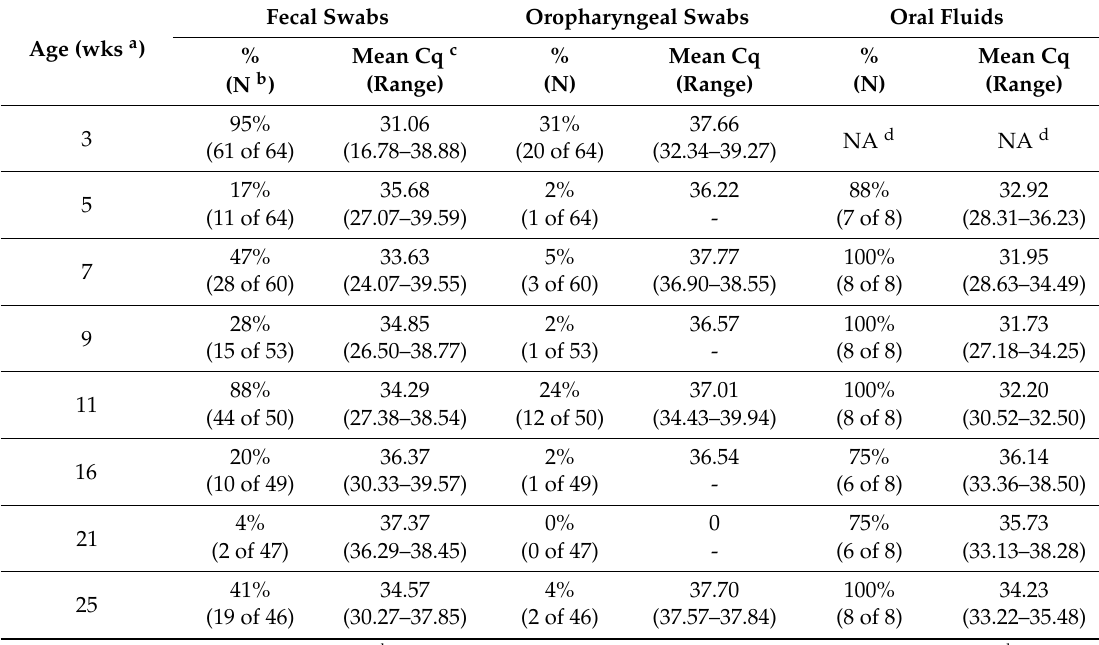
Table 2. PoAstV3 detection frequency and RT-qPCR mean Cq and Cq range by sample type over